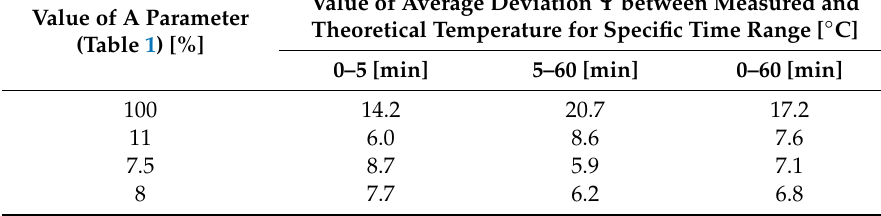
Table 4. Value of average deviation Ψ between measured and theoretical temperature for the assumed A parameter and 3 L / m 2 / h of water.